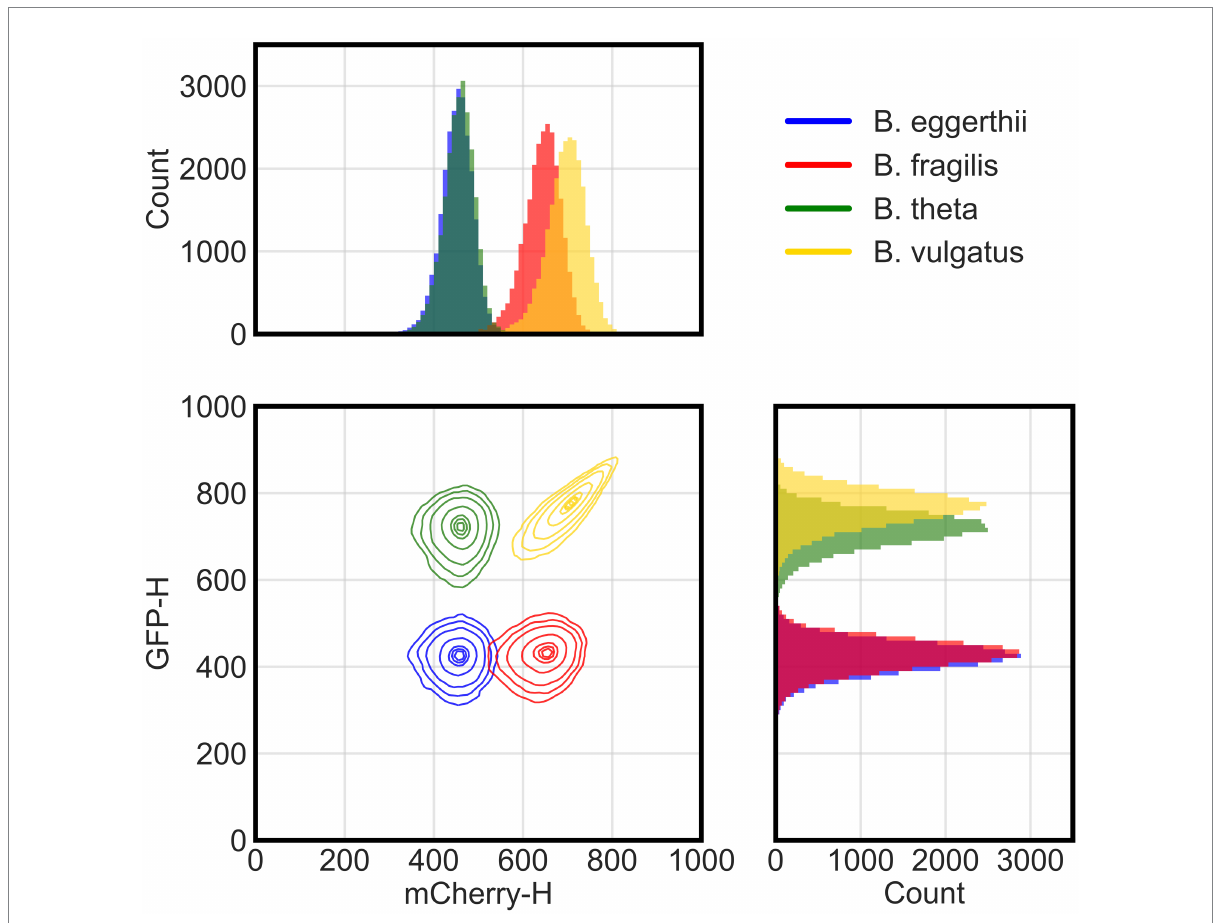
FIGURE 1 Flow cytometry distinguishes four fluorescent Bacteroides species. Flow cytometry analysis of cellular events (total of 25,000 events per species) from four species pooled together post-processing. Species were grown overnight in rich media then washed and incubated in cold